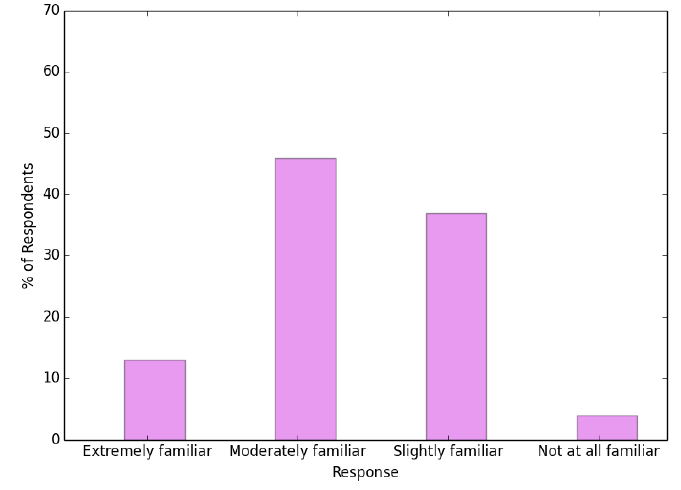
Figure 3. Survey results related to familiarity with ecosystem services.